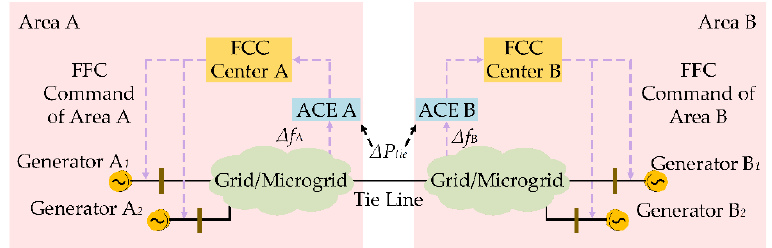
Figure 6. Frequency control schematic of the two-area system.